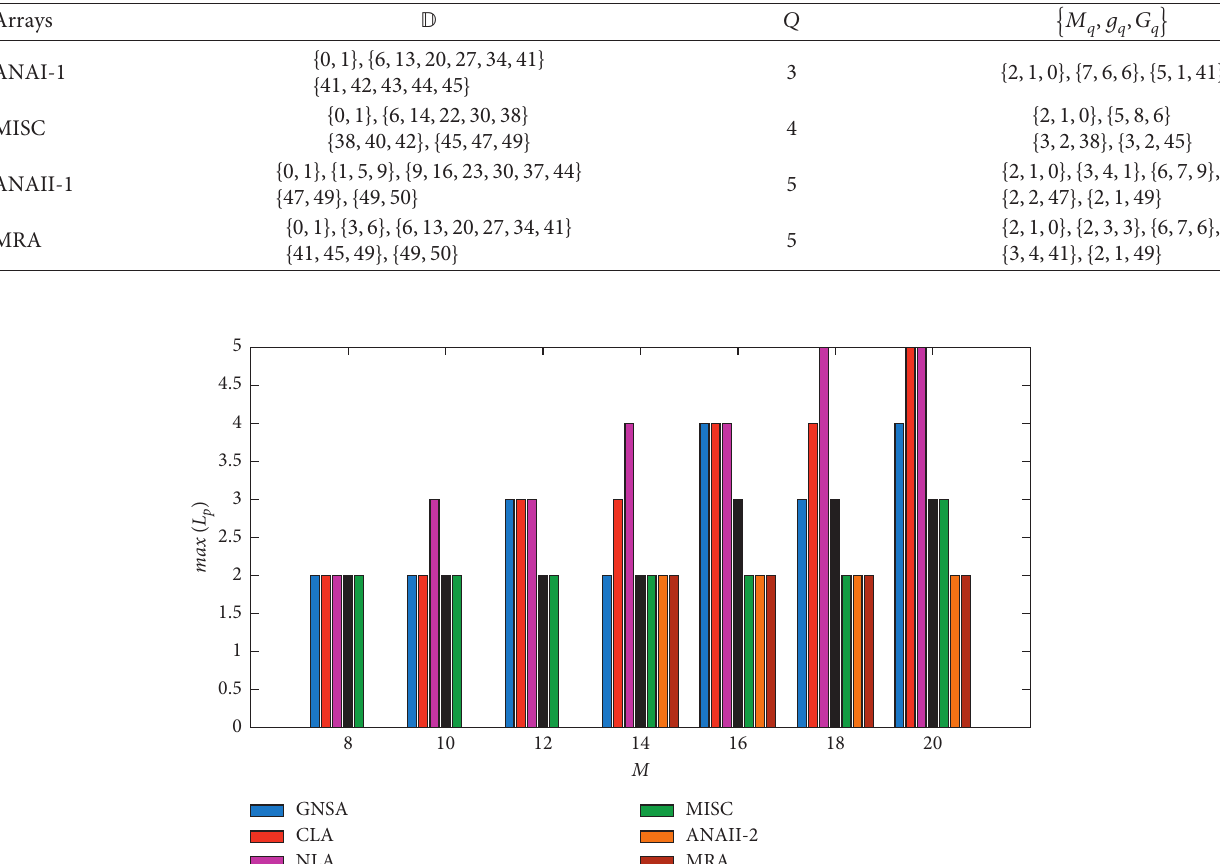
Table 3: Parameters of sparse arrays.